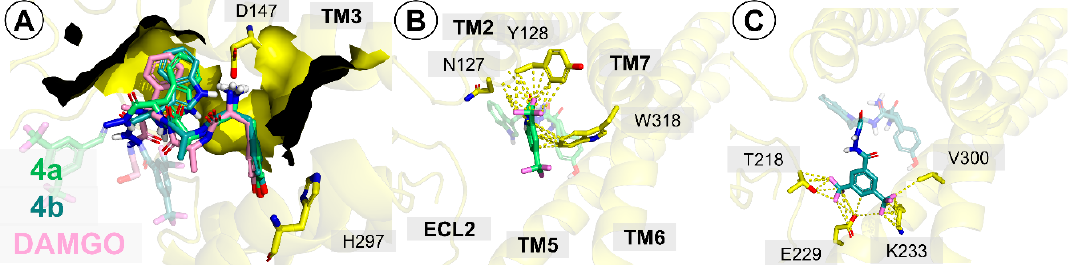
Figure 6. Binding modes of compounds 4a (lime) and 4b (light teal) in the MOR binding site (yellow). The ligands are shown as colored sticks. Several residues and transmembrane helices (relevant for each picture) are shown and labelled. Yellow dotted lines represent interactions. ( A ) Both compounds superimposed on DAMGO (pink, from 6DDF [43]). ( B , C ) Focus on the on the interactions of the C-terminal part, showing compounds 4a ( B ) and 4b ( C